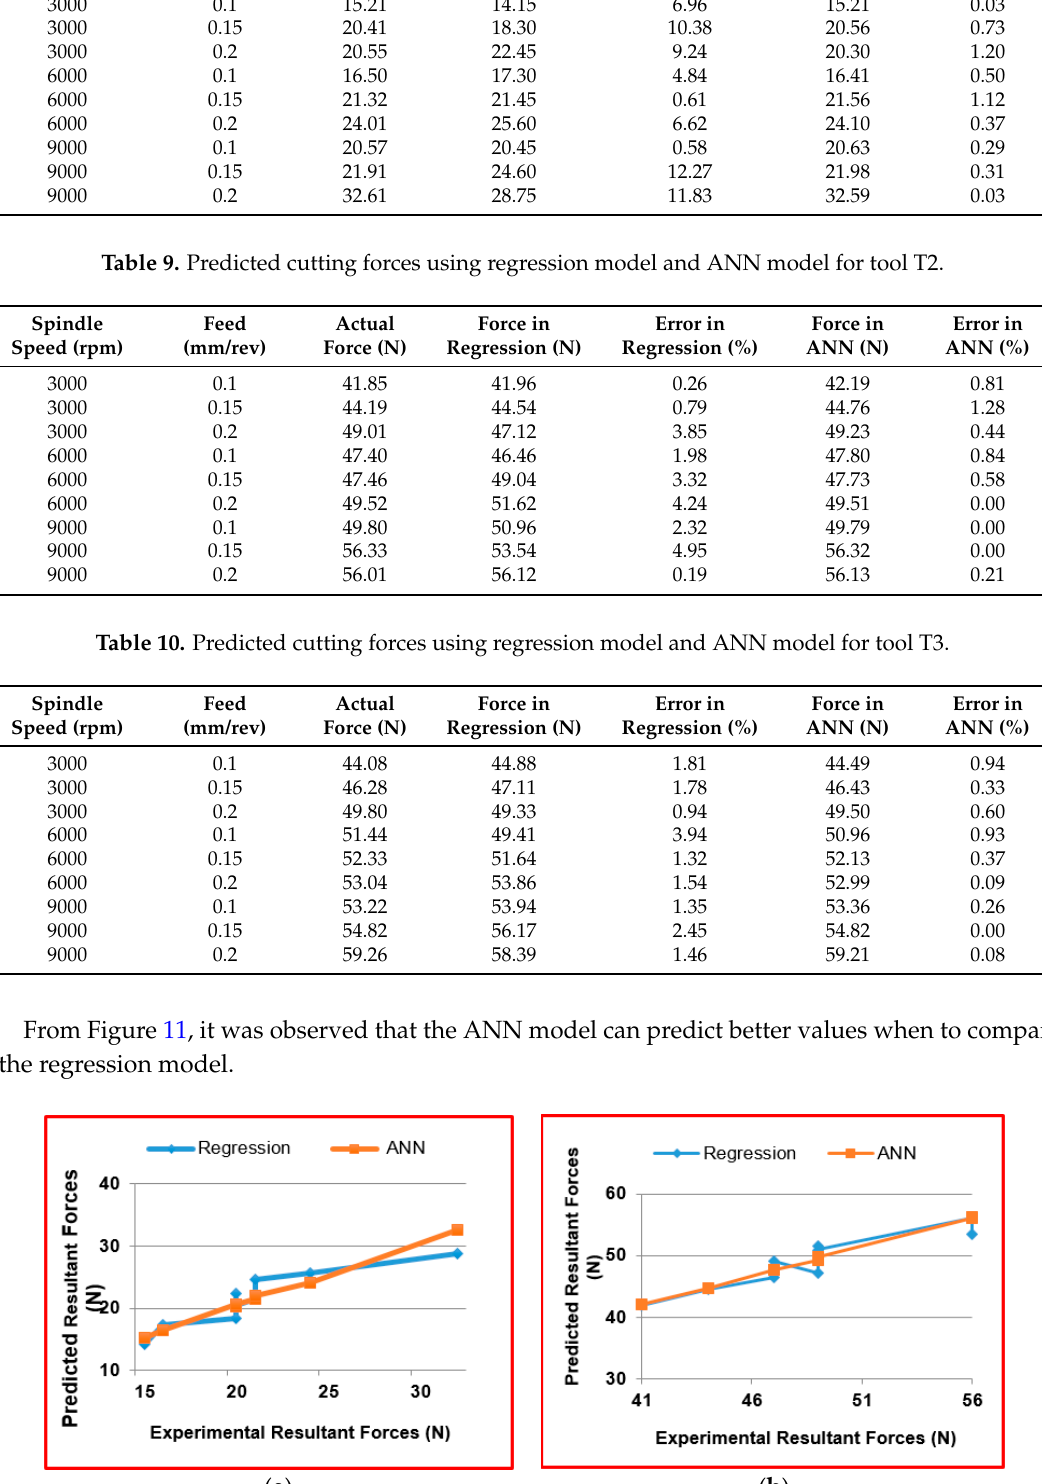
Table 8. Predicted cutting forces using regression model and ANN model for tool T1.